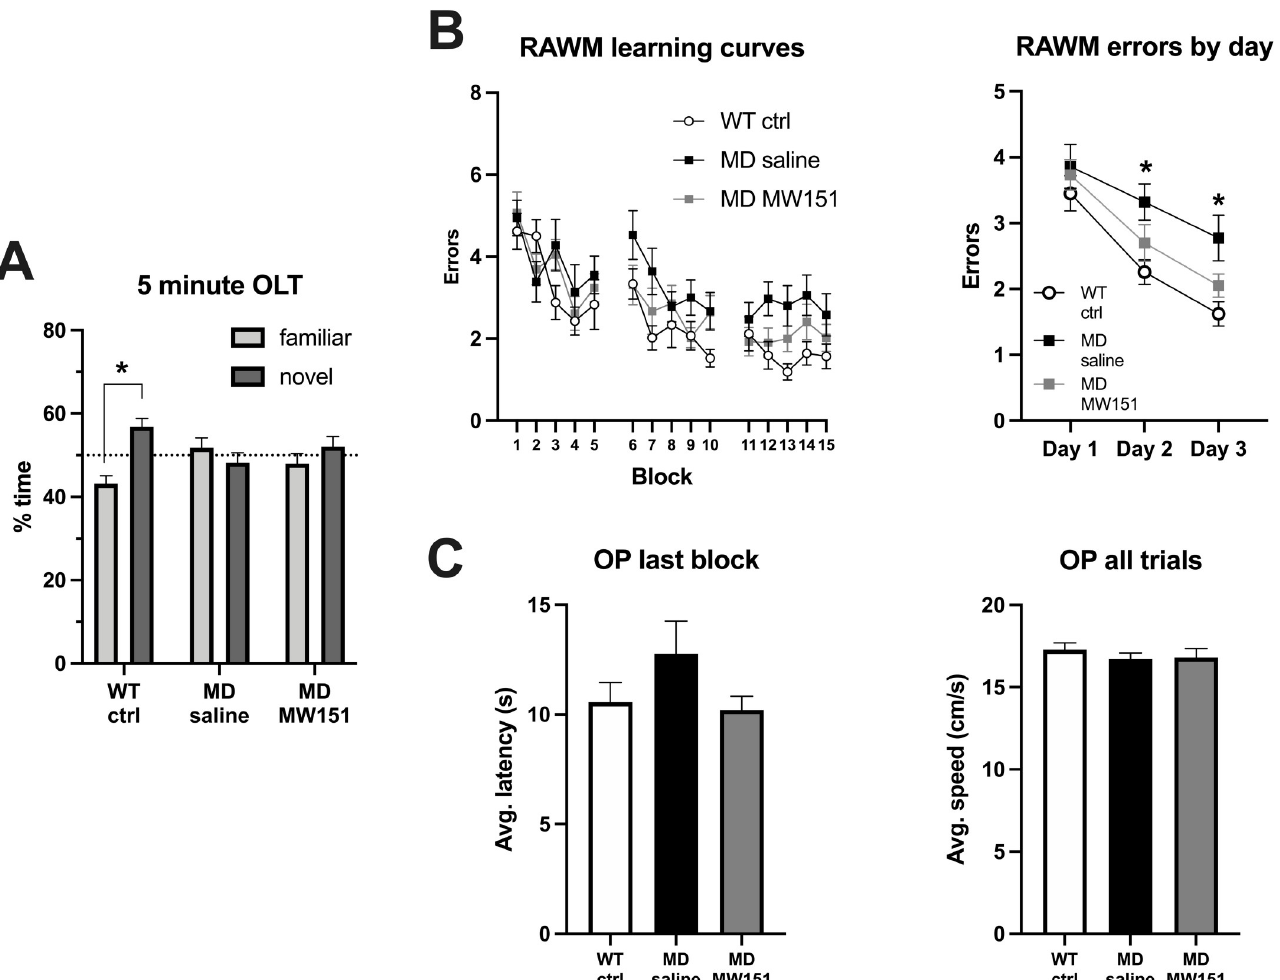
Fig 2. MW151 treatment in MD mice has no effect on OLT performance but may reduce errors in the RAWM. ( A ) Neither the MD saline nor the MD MW151 groups spent significantly more time on average exploring the object in the novel versus the familiar location, in contrast to the WT ctrl group which did show a significant preference for the object in the novel location: multiple paired t-tests with Holm-Sidak adjustment ( T (13) = 3.522, p = 0.0149) � p < .05. ( B ) Learning curves of RAWM errors by block (3 consecutive trials) are shown for the WT ctrl and MD mice in the left panel. Errors are collapsed into average per day for statistical analysis in the right panel. Two-way mixed measures ANOVA showed a significant effect of day ( F (1.955, 97.73) = 41.08, p < .0001) and group ( F (3, 50) = 4.088, p = 0.0113). The MD saline mice (n = 12) committed significantly more errors than WT ctrl on both day 2 and 3 of testing, � p < .05 versus WT ctrl group, Tukey post-hoc comparisons. In contrast, MD MW151 mice did not commit statistically more errors than WT ctrl on any day. There was no significant difference between the MD MW151 and MD saline groups on any of the three days. ( C ) Results of one-way ANOVAs for average latency to platform in the final block ( F (3, 50) = 1.076, p = .368) and average swim speed ( F (3, 50) = 0.278, p = 0.841) indicated no statistical difference between any groups. sides. A circular platform was placed at the end of one of the arms, approximately 1–2 cm below the water’s surface to provide an escape. Animals were split into two groups and tested in a back-to-back 3-day paradigm. Each day consisted of 15 trials (45 trials total), with the first 12 trials on day 1 alternating between hidden and visible (flagged) platform. The platform was hidden for all trials after the first 12. Trials were run in two blocks of 6 and one block of 3 each day. Mice were run in groups of 5–8 at a time, alternating by block to provide time to rest. The goal arm was fixed for each mouse but varied between animals, and each mouse started from a different arm between trials. The start arm sequence was randomized in reference to the goal arm, but with a pattern consistent for all mice. Errors were defined as entry from the pool